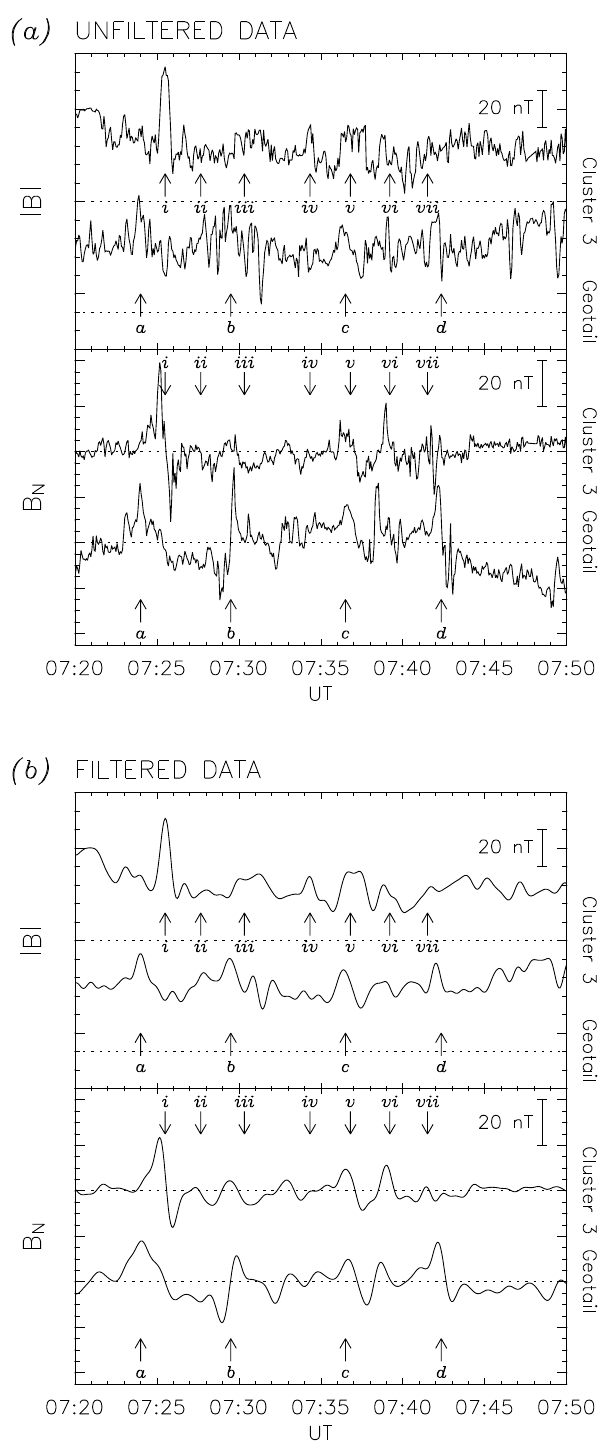
Fig. 6. (a) A comparison of | B | and B N measurements from Cluster 3 and Geotail. FTEs identified previously are indicated by arrows, labelled i–vii (Cluster) and a–d (Geotail) as in Figs. 3 and 5, respec- tively. (b) the same data as (a), but band-pass filtered in order to reveal the FTE signatures more